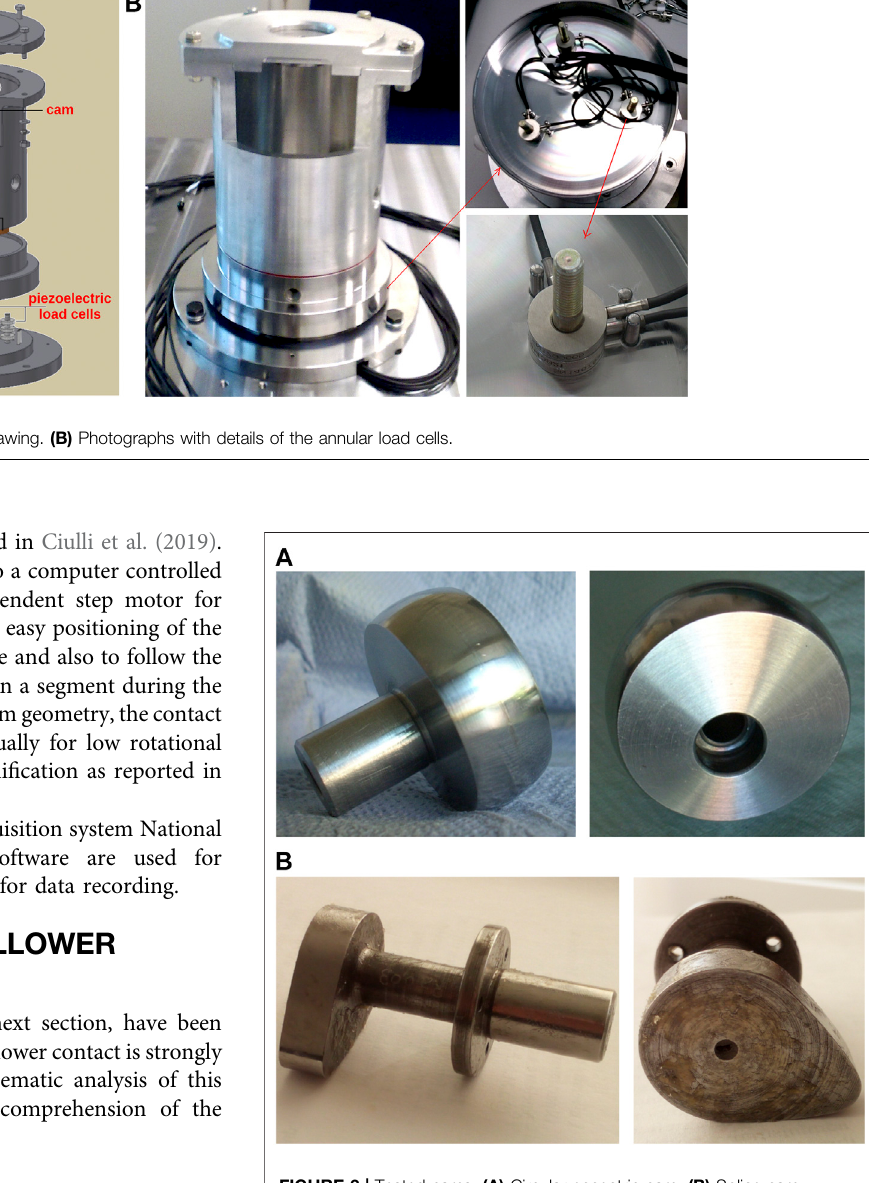
FIGURE 3 | Tested cams. (A) Circular eccentric cam. (B) Spline